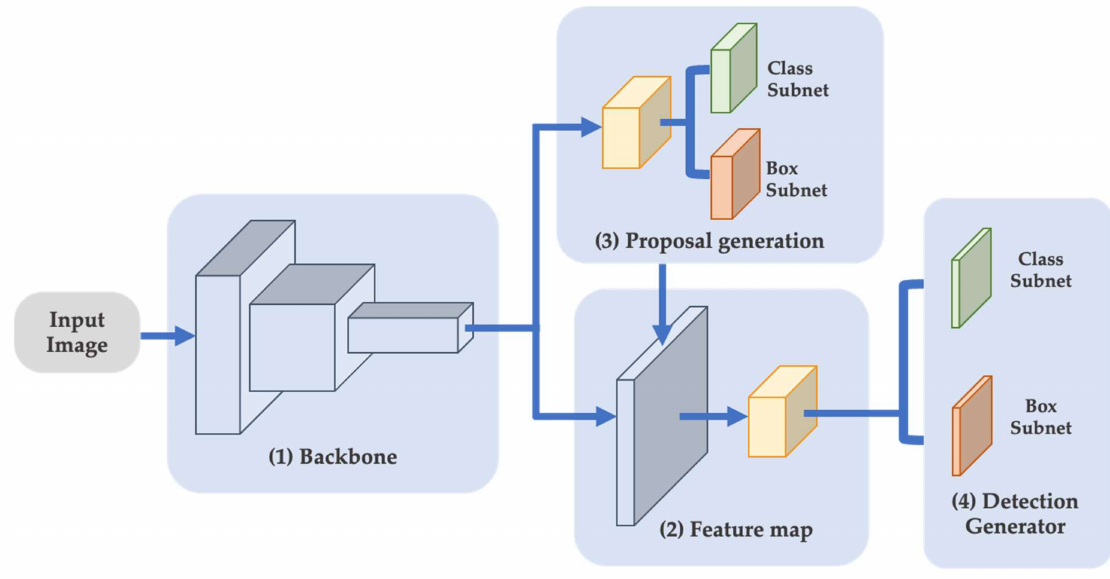
Figure 2. Two-stage object detection